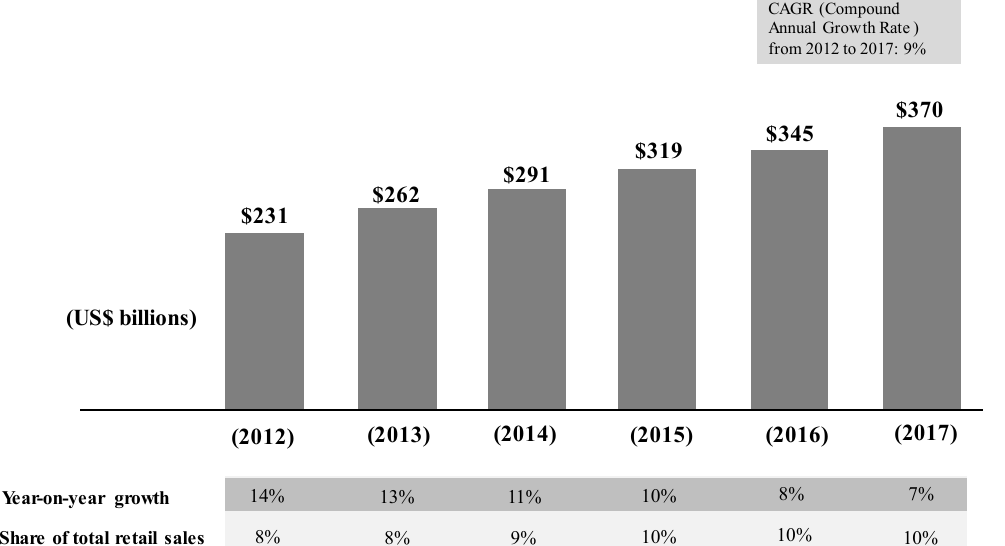
Figure 16. Ever increasing online retail [54,55].